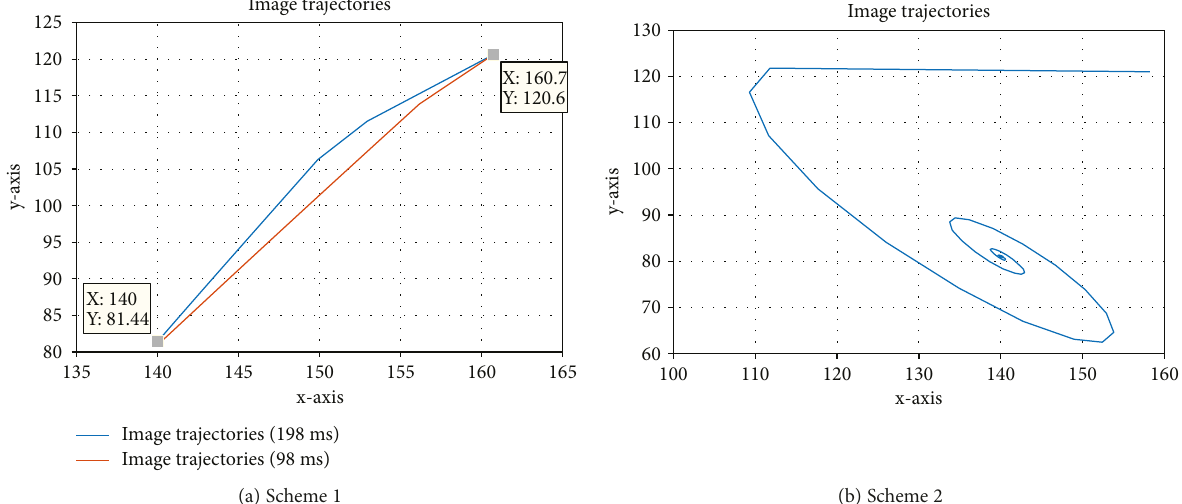
Figure 7: Position trajectory of the feature point on the image